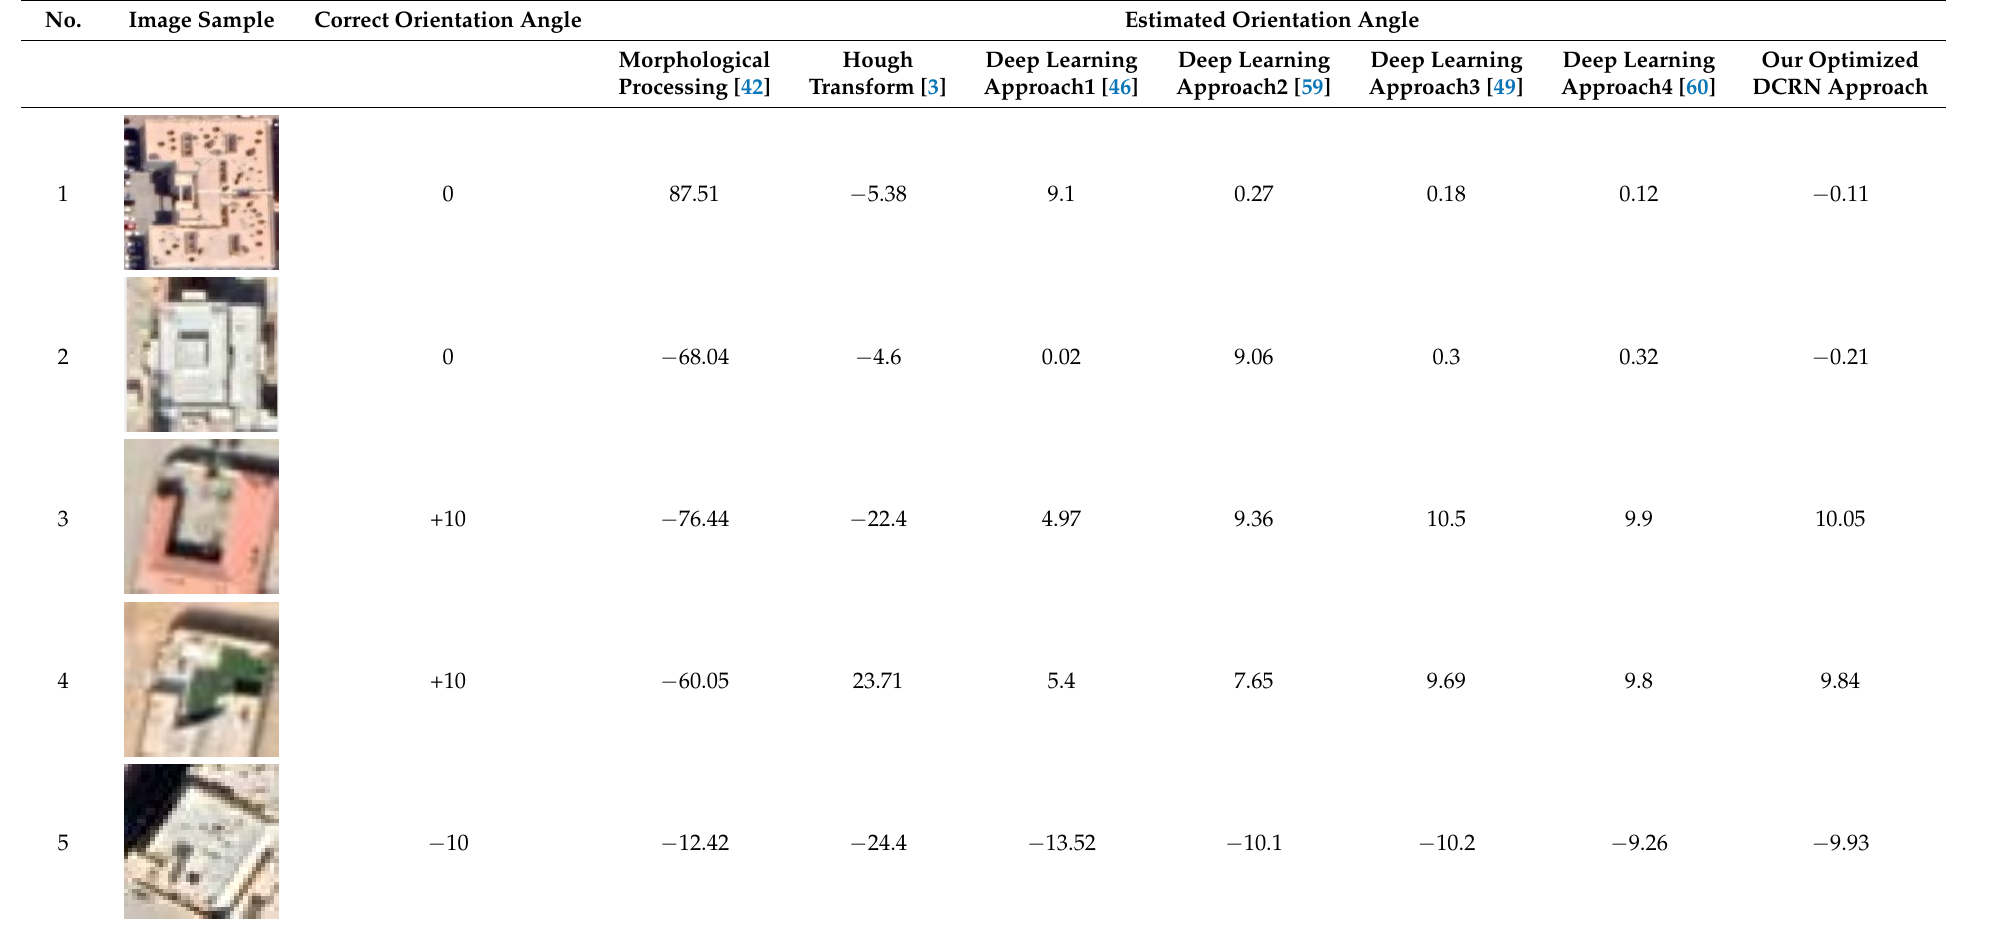
Table 7. Our proposed approach building orientation angle estimation results vs. previous